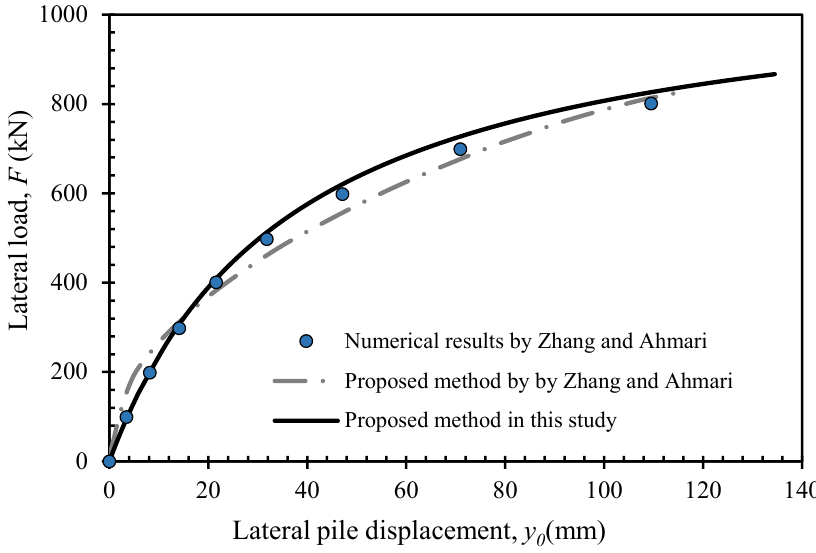
Figure 11. Comparison of the load displacement results for case 2 [22].